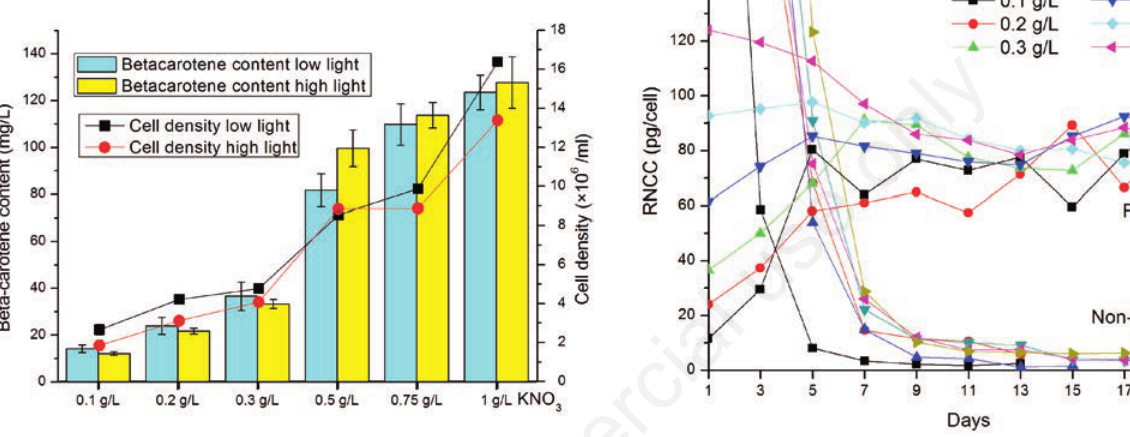
Figure 1. The cell density and beta-carotene content under differ- ent light intensity and KNO added at the first day; all values were collected at 15 th cultivation day.